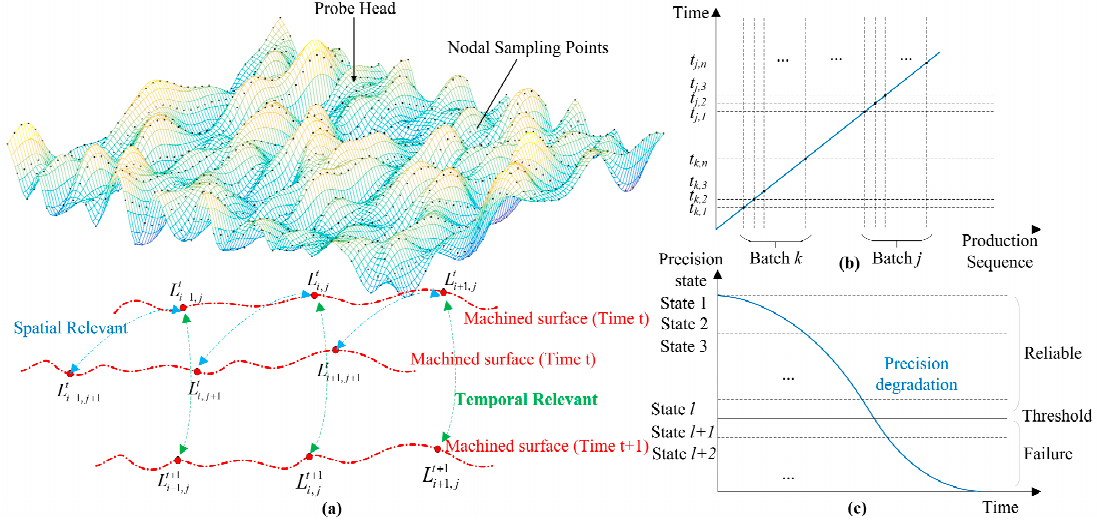
Figure 1. Temporal and spatial Markov properties of planar machining surface ( a ), and an illustration of the precision state degradation in the production sequence ( b , c ).